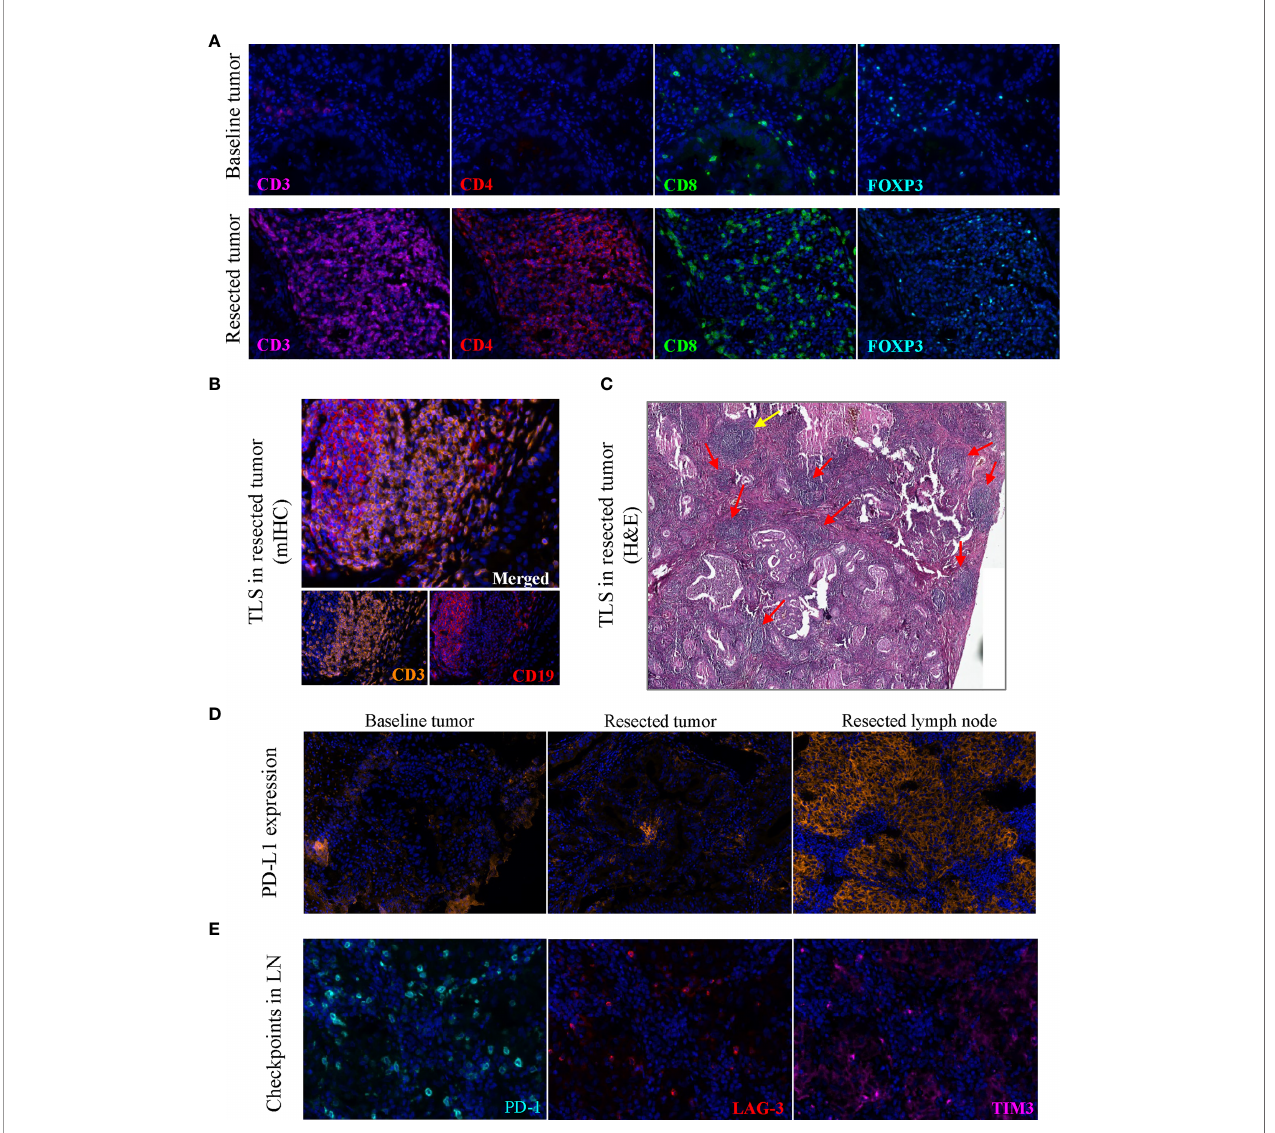
FIGURE 2 | Images oftertiarylymphoid structures and immune cellmarkers. (A) Images showed the abundant CD3 + , CD4 + , CD8 + and FOXP3 + cellsinpost-treatment tumor onthe same slide, with the markersstained on baseline tumor as a contrast. (B) TLSinthe post-treatment tumorstained bymultiplex immunohistochemistry. (C) TLSs on a hematoxylinand eosin-stained section, yellow arrow indicates a mature TLSwith a palearea, redarrow indicates immature TLSs. (D) PD-L1expression in the baselinetumor,post-treatment tumor and post-treatment lymph node tissue. (E) Immune checkpoint proteins PD-1, LAG-3, TIM3in the post-treatment lymph nodetissue. Originalmagni fi cation of fl uorescence image: 200×. TLS, tertiary lymphoid structure; LN, lymph node; mIHC, multiplex